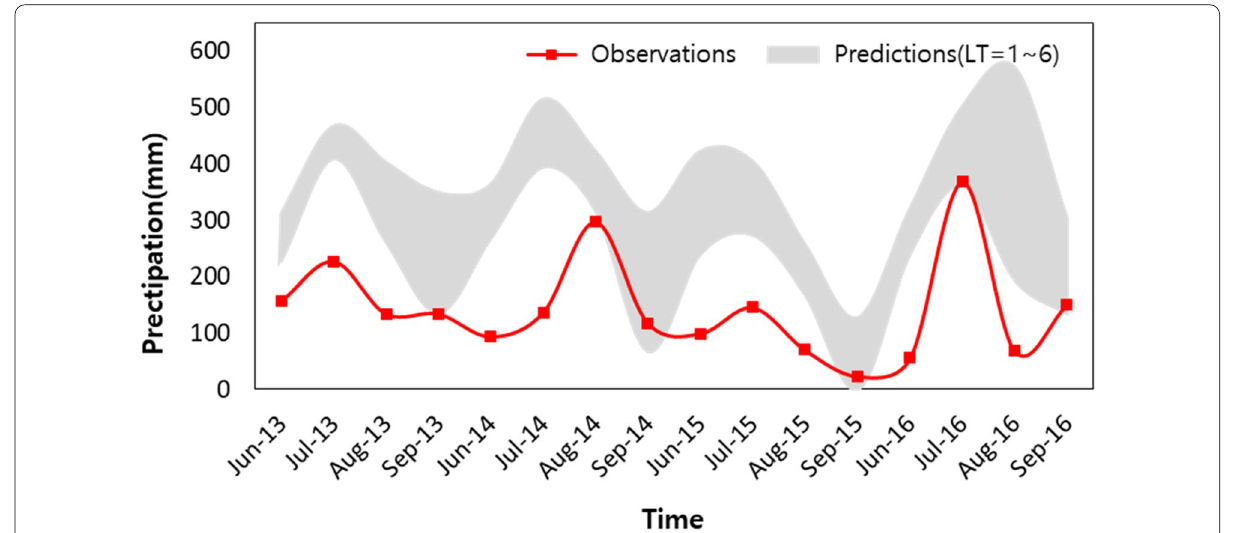
Fig. 10 Results of the modified precipitation prediction